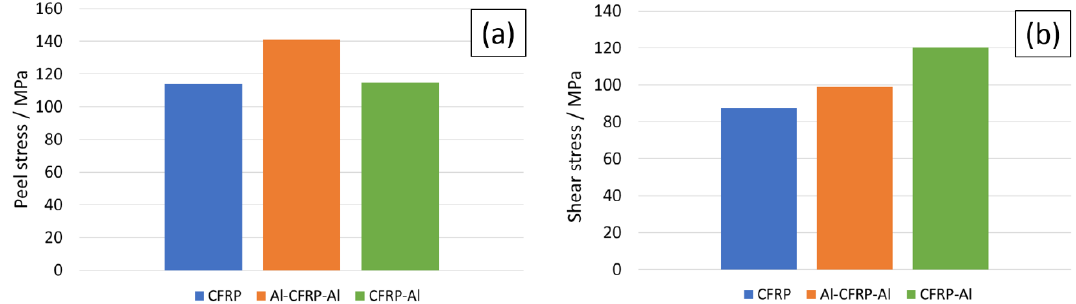
Figure 8. Maximum values for ( a ) peel stress and ( b ) shear stress for all the geometries.